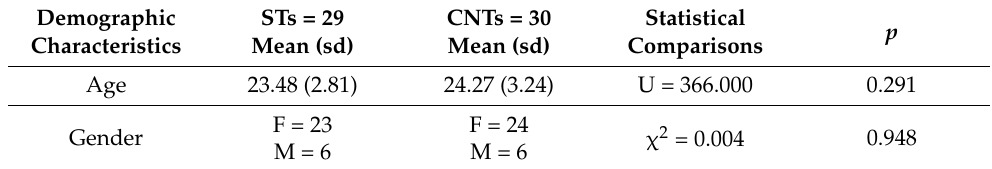
Table 1. Results of the comparisons concerning demographic characteristics.